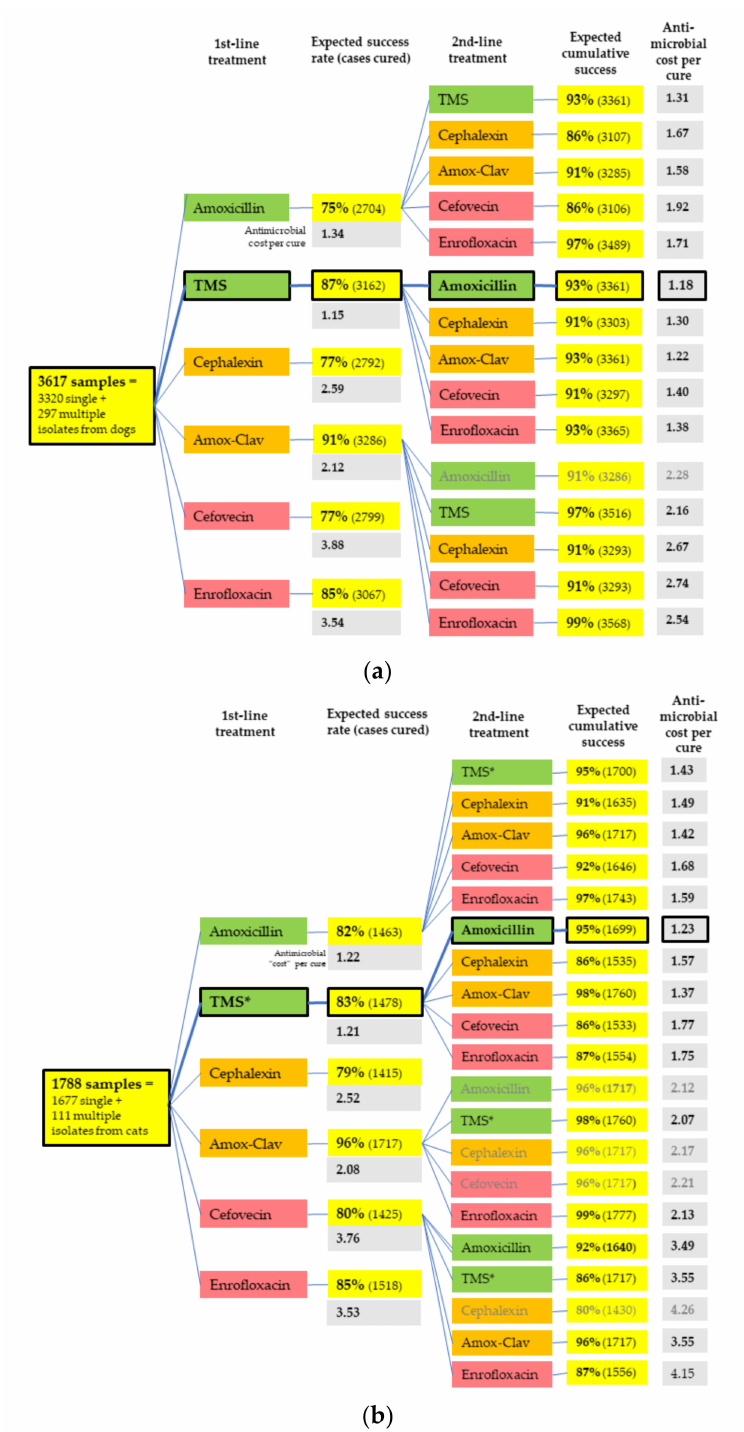
Figure 4. Whole population treatment simulation, including antimicrobial cost per cure in ( a ) dogs and ( b )cats. Amox-Clav = amoxicillin-clavulanate. Boldoutlinesindicatethebestpathwaysbyantimicrobial cost. Colors indicate the ASTAG importance ratings of antimicrobials [9], where green are the least important (preferred choices), and red are the most important (least preferred choices), due to the risk that selection of resistance poses to human and animal health. Only selected second-line pathways are displayed—those with the lowest antimicrobial cost per cure and those following first-line choices that are most commonly used for UTIs in that animal species in Australia—amoxicillin-clavulanate in dogs and cefovecin and amoxicillin-clavulanate in cats [2] (unpublished